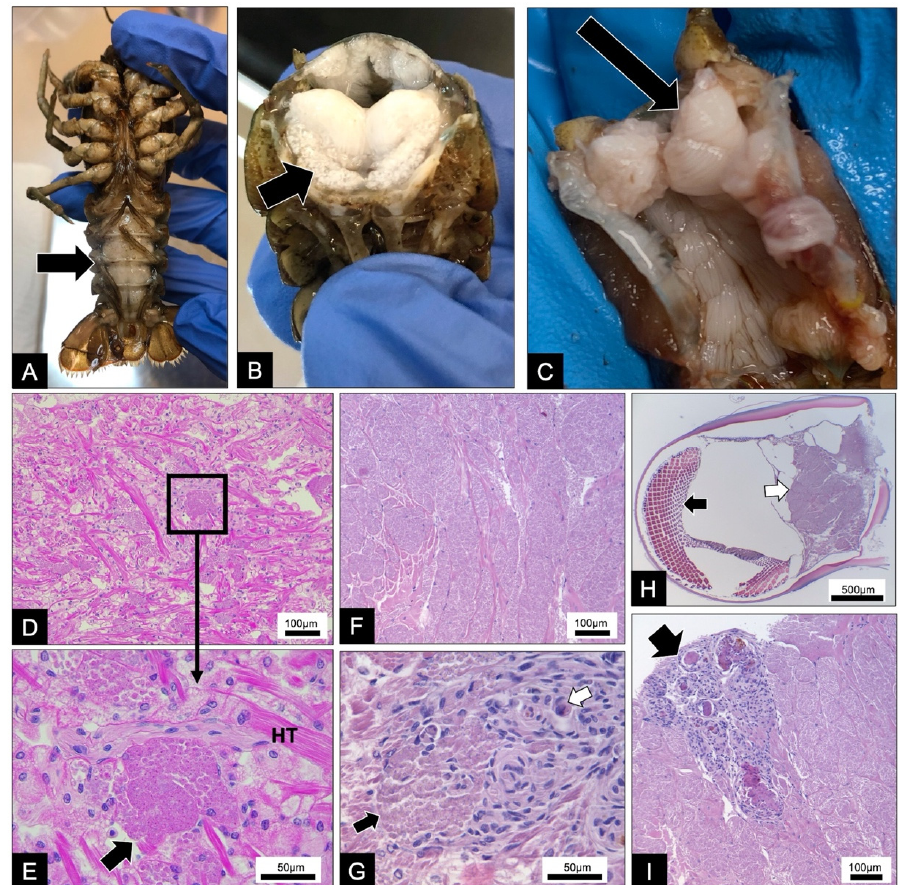
Figure 1. Gross pathology and histopathology of microsporidian infections in Faxonius virilis and Faxonius rusticus : ( A ) muscle tissue of infected crayfish is white and visible through the ventral cuticle of the abdomen (black arrow); ( B ) a transverse section of the abdomen reveals white muscle tissue (black arrow) presumably due to infection; ( C ) during dissection, white muscle tissue throughout the body cavity was white (black arrow) from the infection; ( D ) heart tissue with groups of developing spores; ( E ) a higher magnification of ( D ) of one cluster of developing spores in the heart tissue (HT) and the evident sporophorous vesicles containing the spores (black arrow); ( F ) abdominal muscle tissue exhibiting a heavy microsporidian infection; ( G ) high magnification image of a cluster of spores (black arrow) developing within the heart tissue and the production of granulomas (white arrow); ( H ) microsporidian spores (white arrow) developing within the muscle stalk of the eye (black arrow); ( I ) an immune response to the microsporidian infection in the abdominal muscle resulting in the production of several granulomas (black